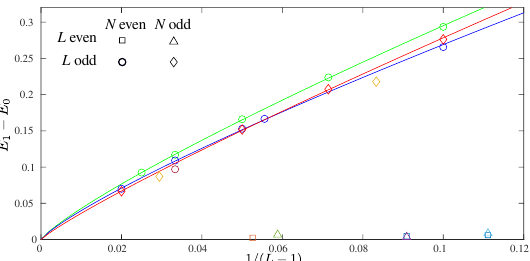
Figure 17: (Color online) Scaling of the lowest magnetic gap in a strong-backbone regime. Very low excitation energy (of the order of 10 − 3 ) is detected for L even (squares and triangles). For odd L the finite-size gap is much larger, but van- ishes in the thermodynamic limit. Lines are the result of the fit of equal- N data to ∝ ( L − 1 ) − d L . The resulting values of the scaling dimension are within the range < 0.83 < d N